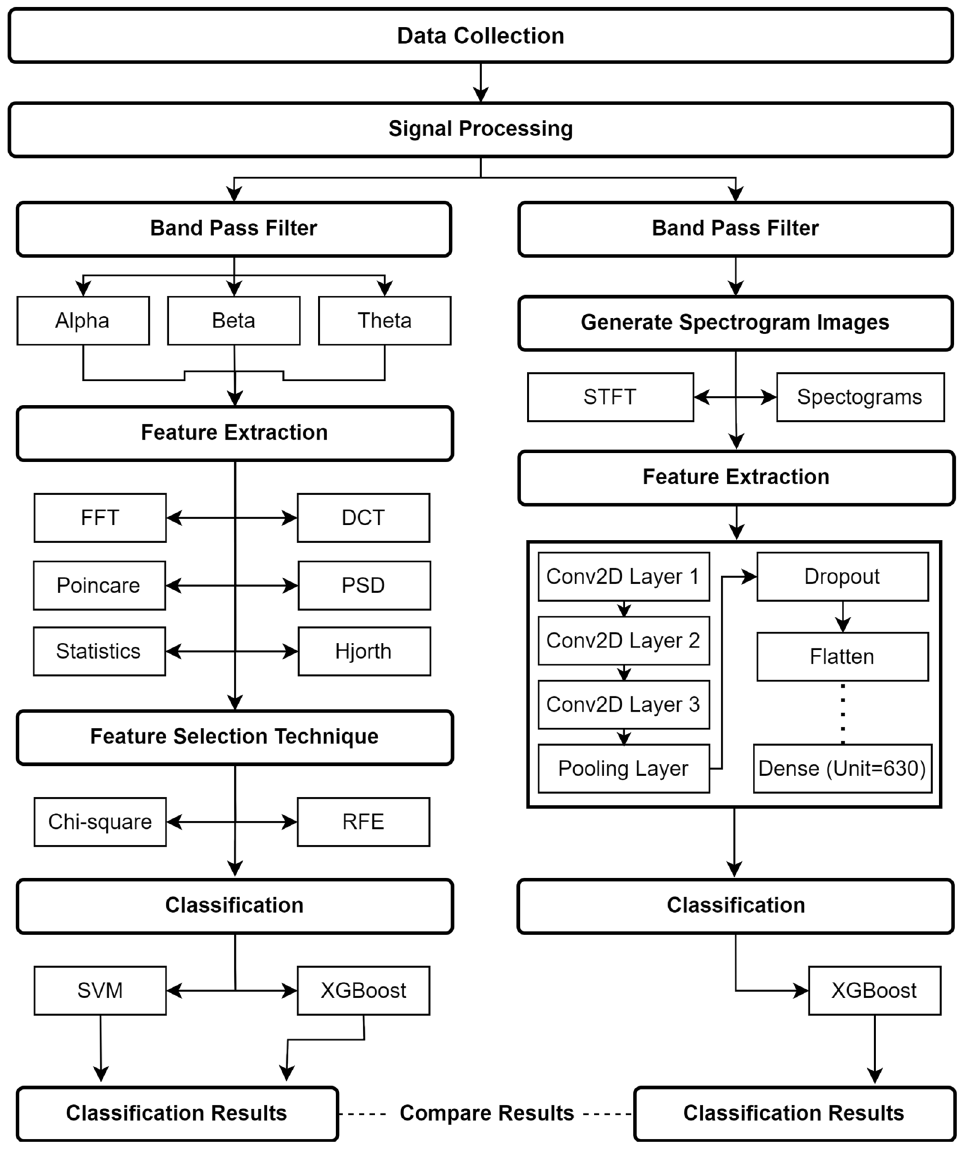
Figure 1. An overview of the proposed method.